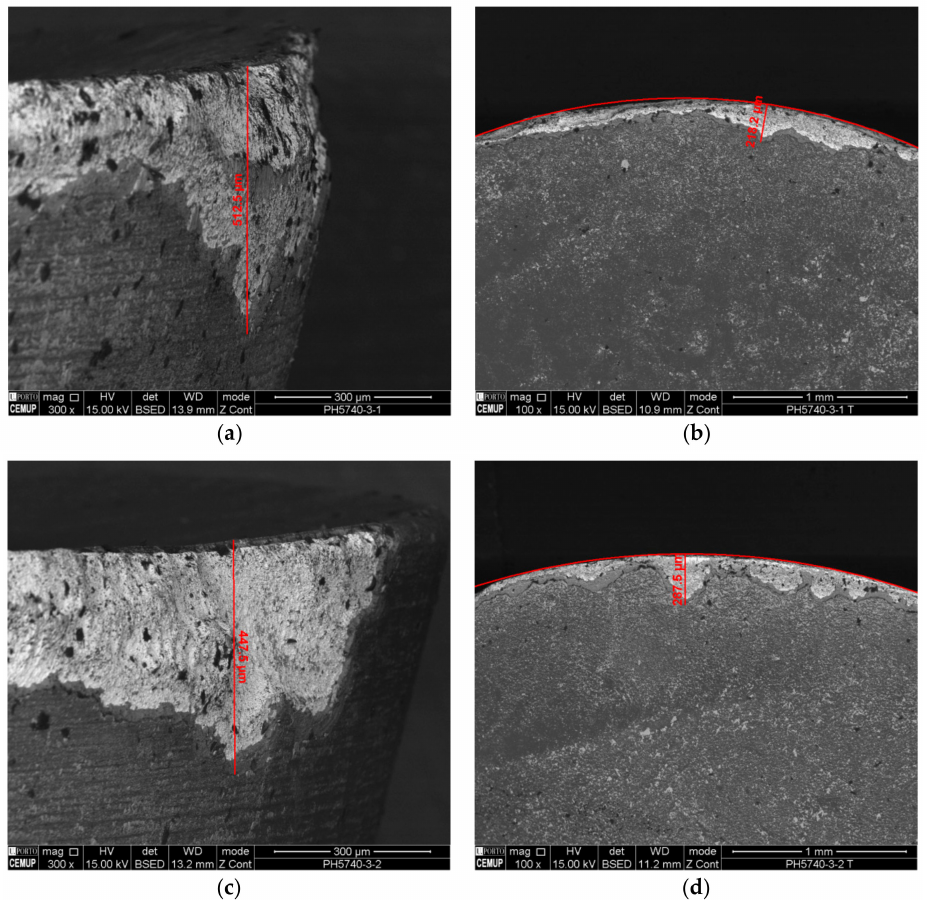
Figure 10. ( a , c ) flank wear (VB) of CVD TiN / TiCN / Al 2 O 3 PH5740-S1 and PH5740-S2 cutting inserts, respectively; ( b , d ) crater wear (KB) of CVD TiN / TiCN / Al 2 O 3 PH5740-S1 and PH5740-S2 cutting inserts, respectively.